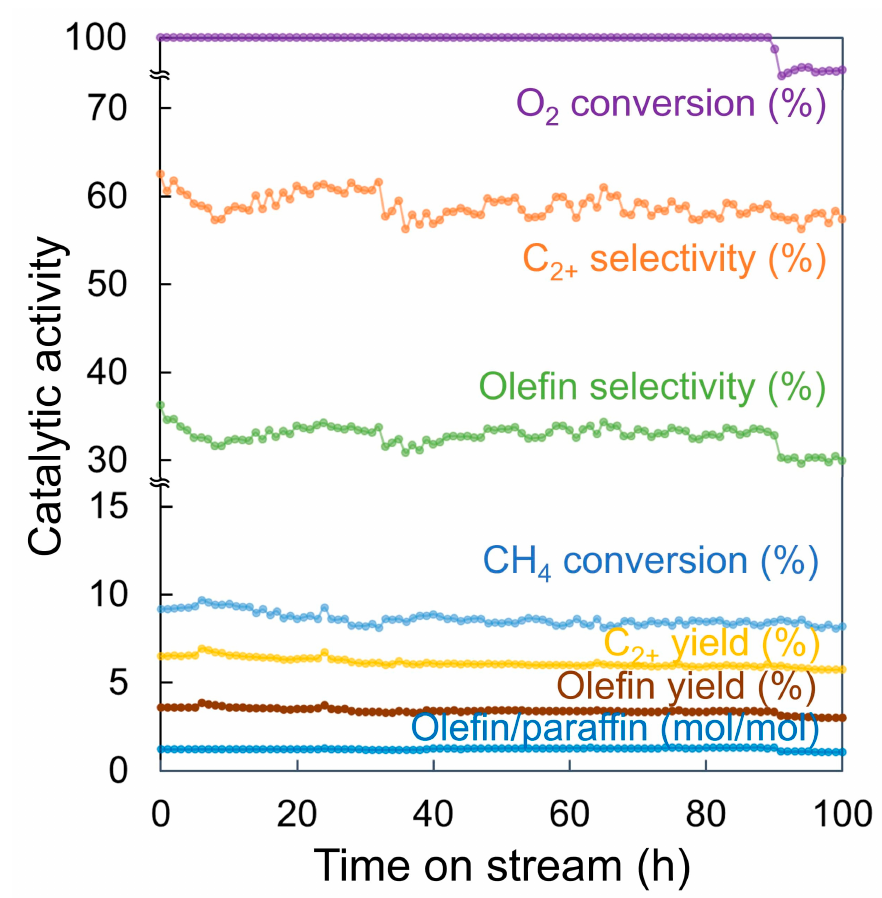
Figure 9. Long-term oxidative coupling of methane results of simulated biogas using N(8)M(0.5)P(1.5).